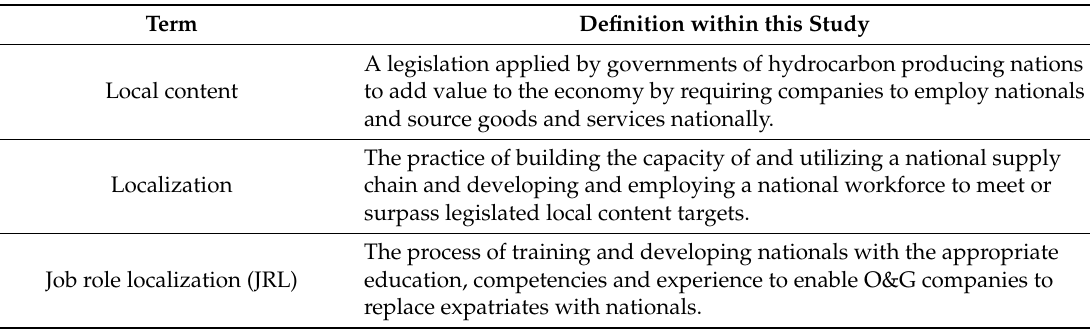
Table 3. Researcher definitions of local content, localization and job role